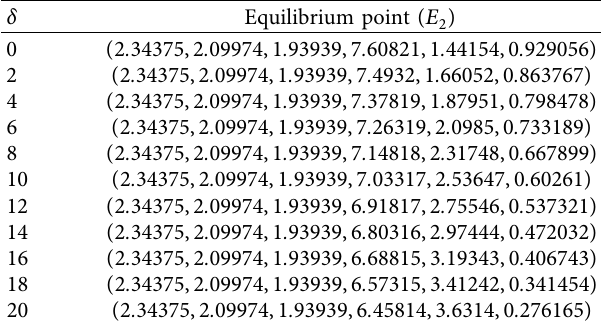
Figure 19: Effect of m � m Table 2: Equilibrium points for different δ